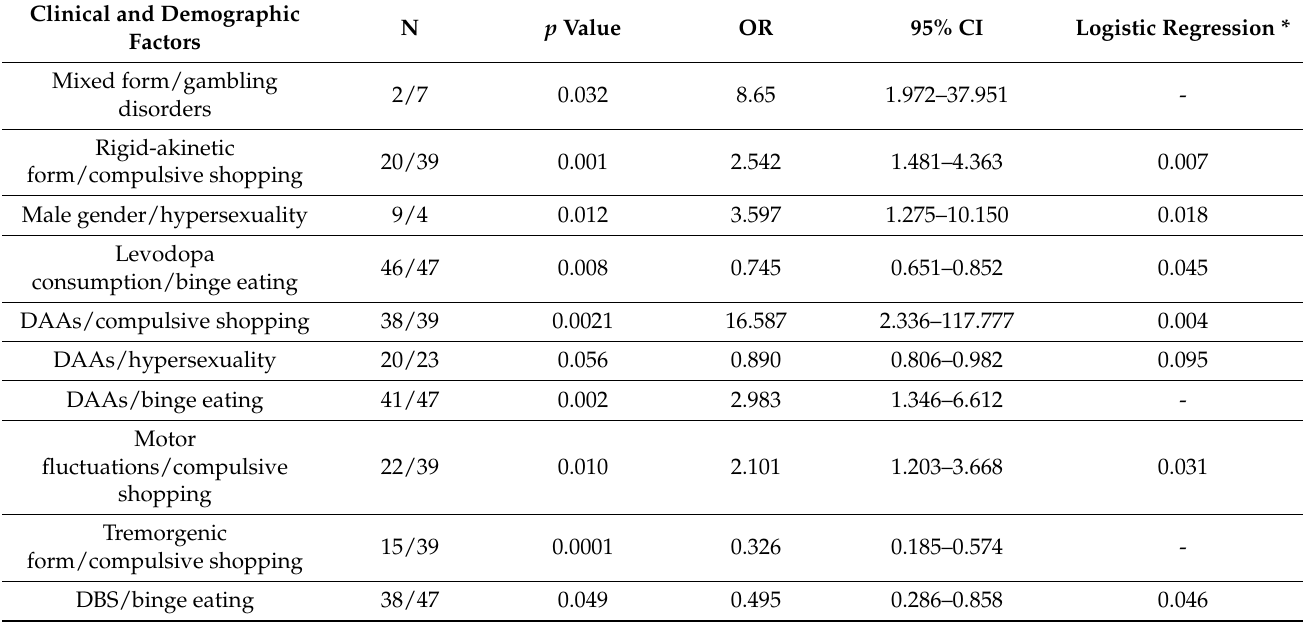
Table 4. Clinical and demographic factors, and their association with a spectrum of